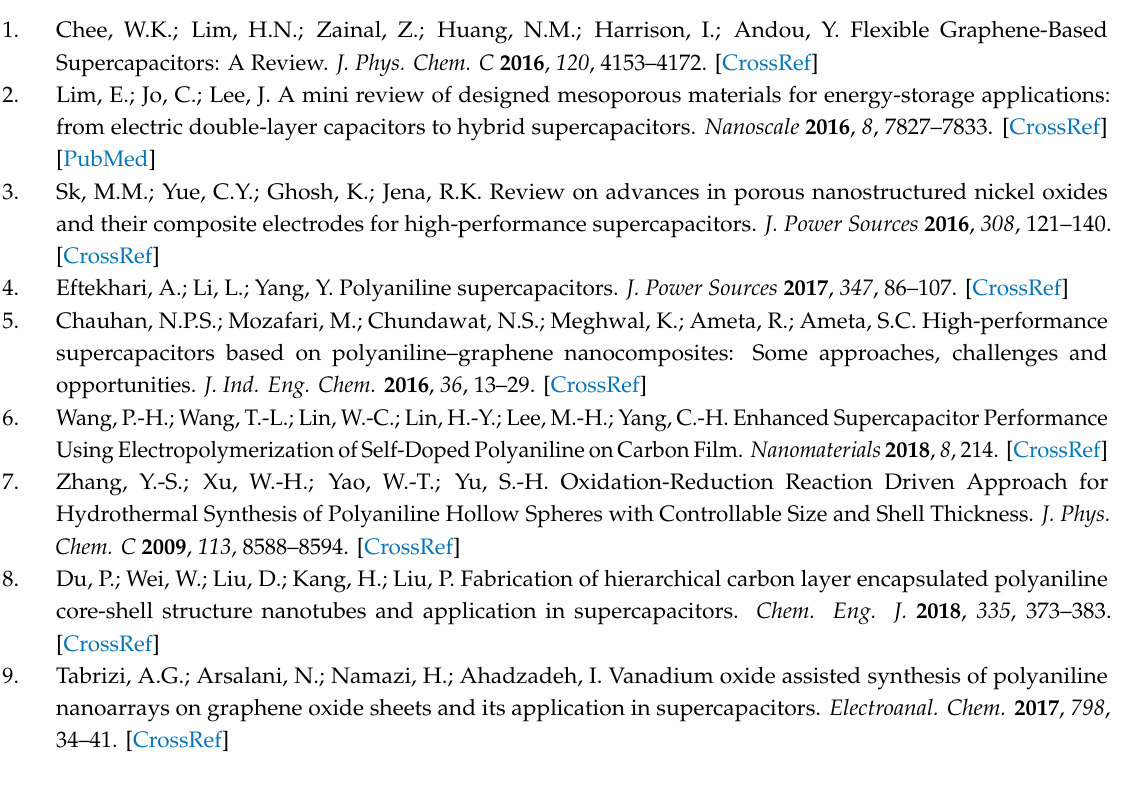
Table S1: The performance of graphene and PANI composites for